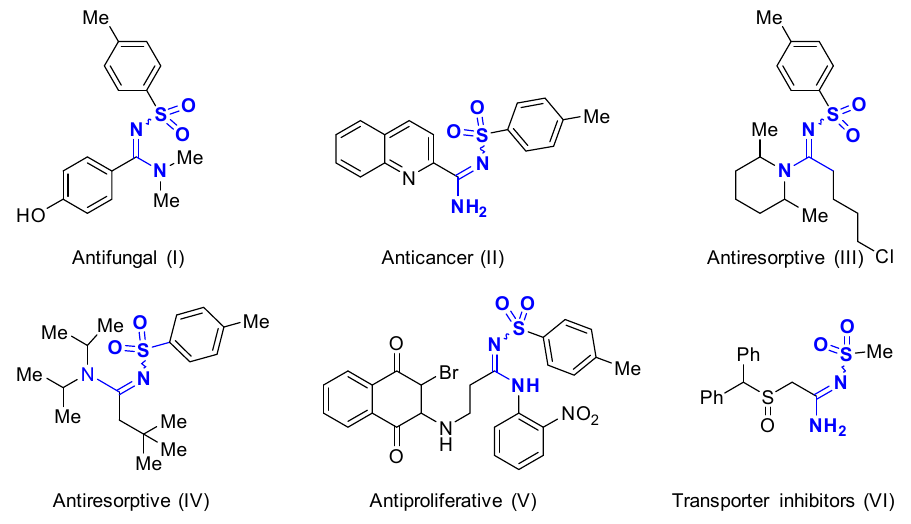
(VI)Me Figure 1. Part of the sulfonyl amidine drug candidates. Figure 1. Part of the sulfonyl amidine drug